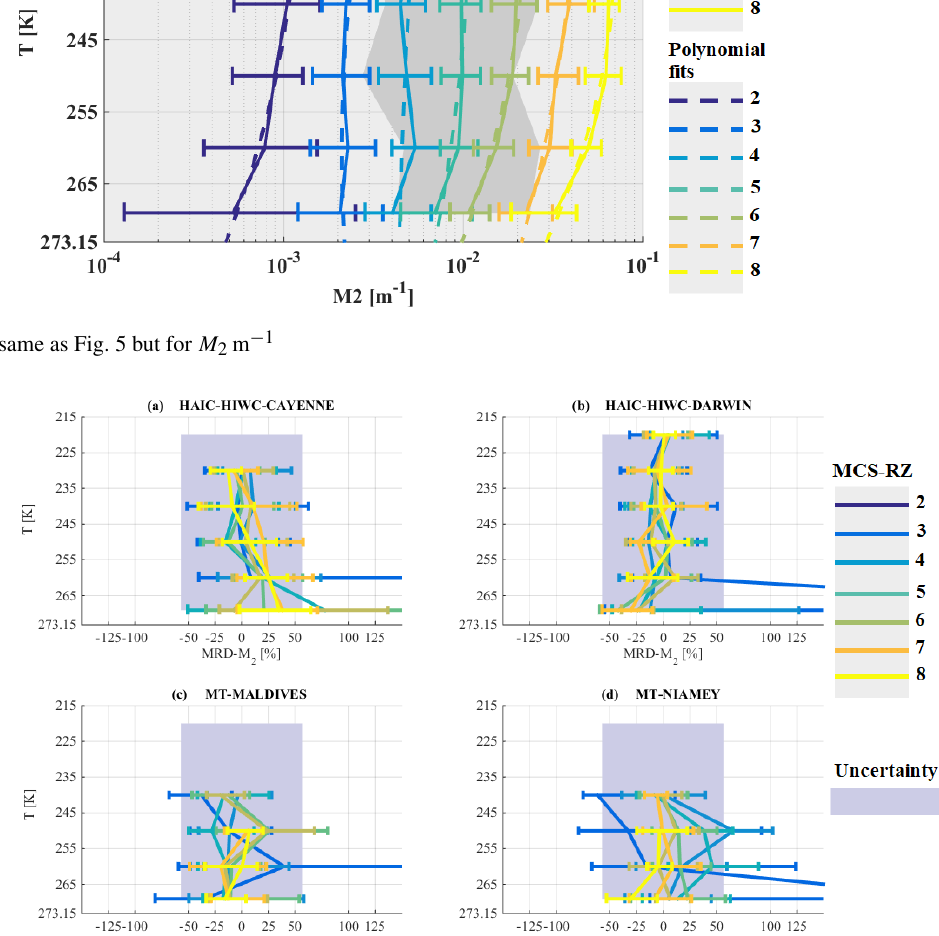
Figure 22. The same as Fig. 6 but for MRD- M 2